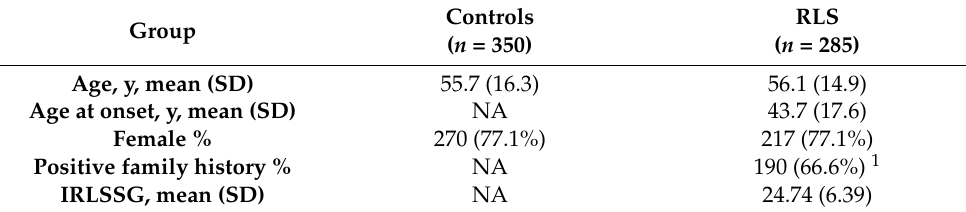
Table 5. Demographic and clinical data of the series studied.